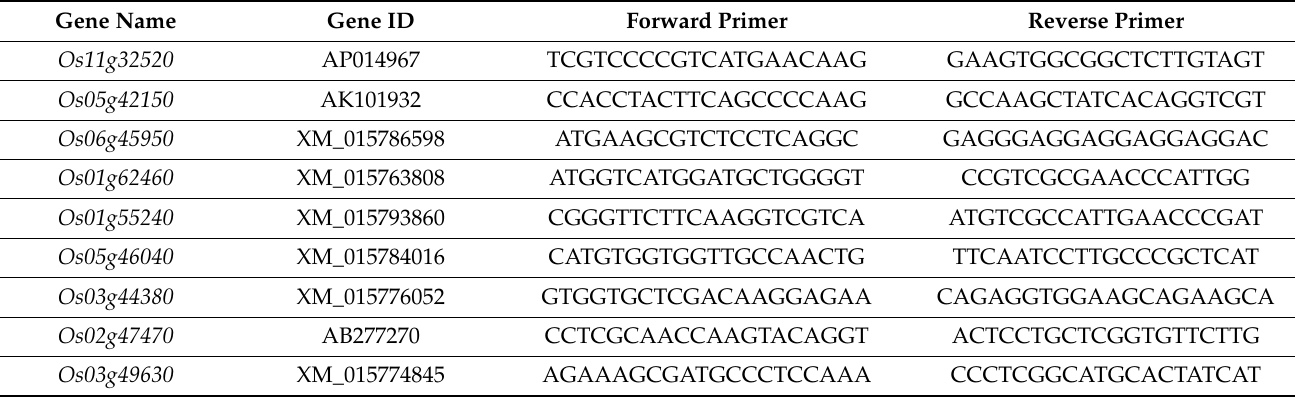
Table 1. Primers for qRT-PCR expression